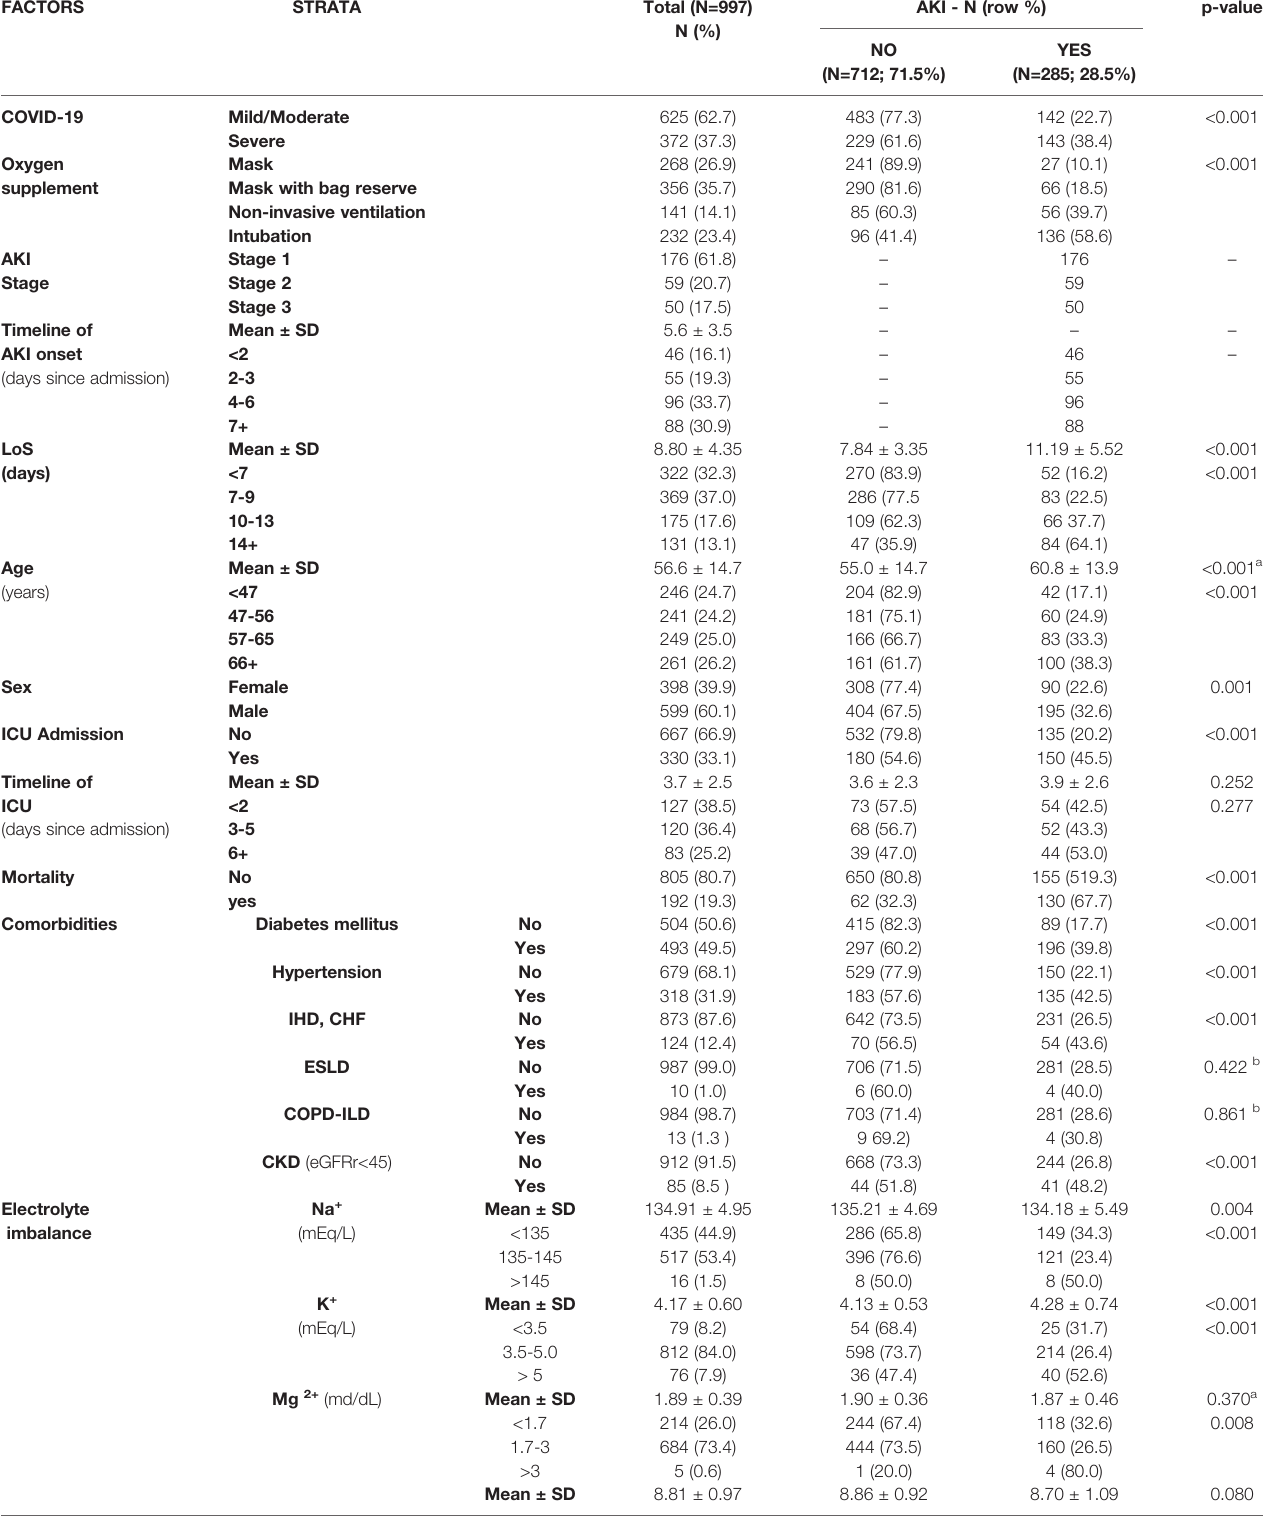
TABLE 1 | Distribution of COVID-19 patients by Acute Kidney Injuries (AKI). Number (N), column percentage (%) and p-value of ANOVA (mean differences) or chi square test (difference in proportions).